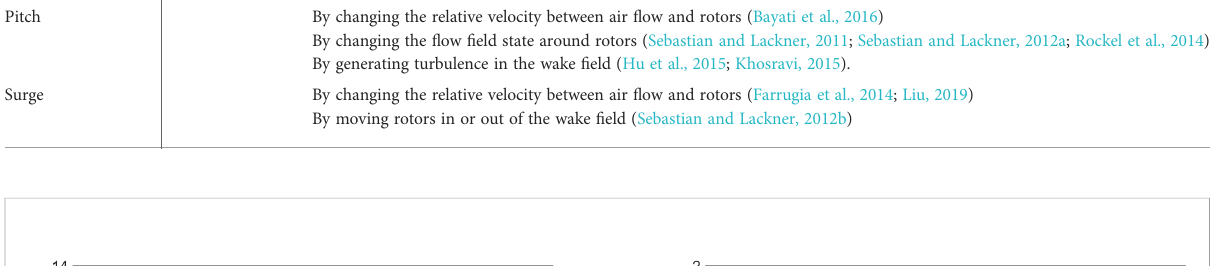
TABLE 3 The impact of pitch and surge on aerodynamics of FWTs.